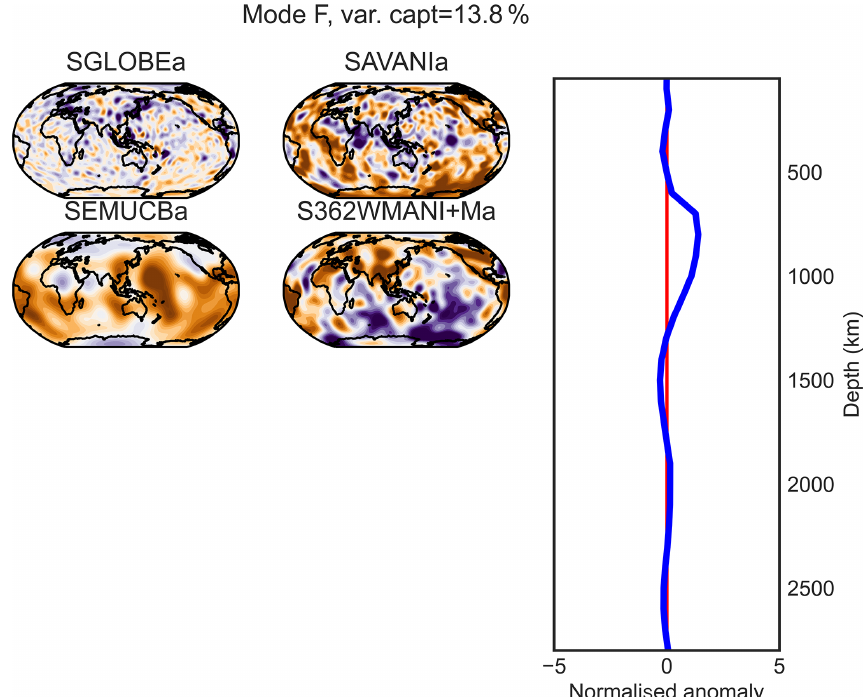
Figure E6. PC F (maximum at 800km of depth) of the combined analysis of the anisotropic parts of the models.